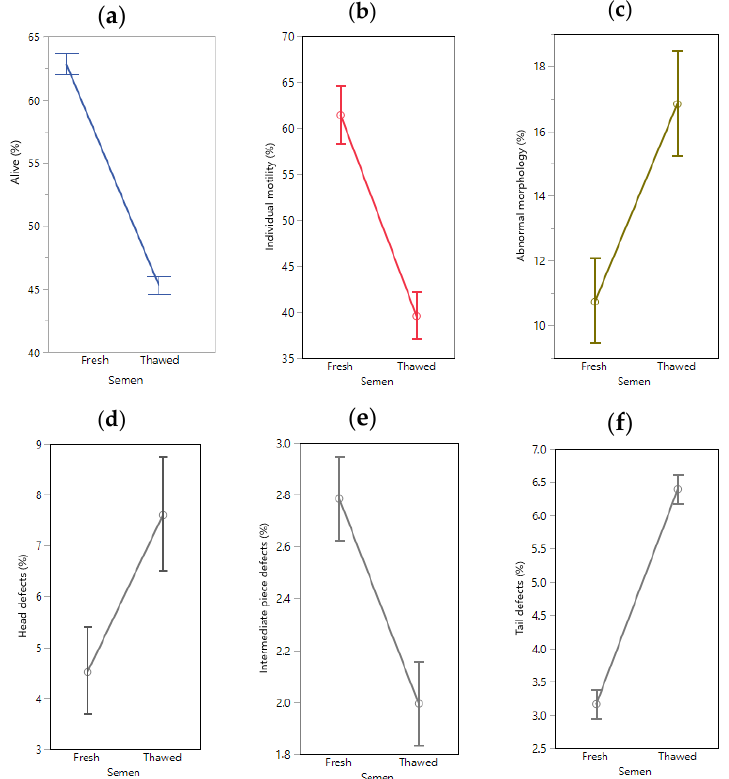
Figure 1. LSmean differences ( p < 0.001) of spermatozoa alive ( a ), individual motility ( b ), abnormal morphology ( c ), head ( d ), intermediate piece ( e ) and tail ( f ) defects in fresh and thawed semen for 10 Portuguese local ram breeds. The vertical bars represent the 95% confidence interval. In fresh semen, the breed effect on four SPZ traits, namely SPZ alive, abnormal morphology, head D, and IPD), was observed (Table 5). Table 5. Effects of breed and breed × semen processing interactions on spermatozoa traits of fresh semen.